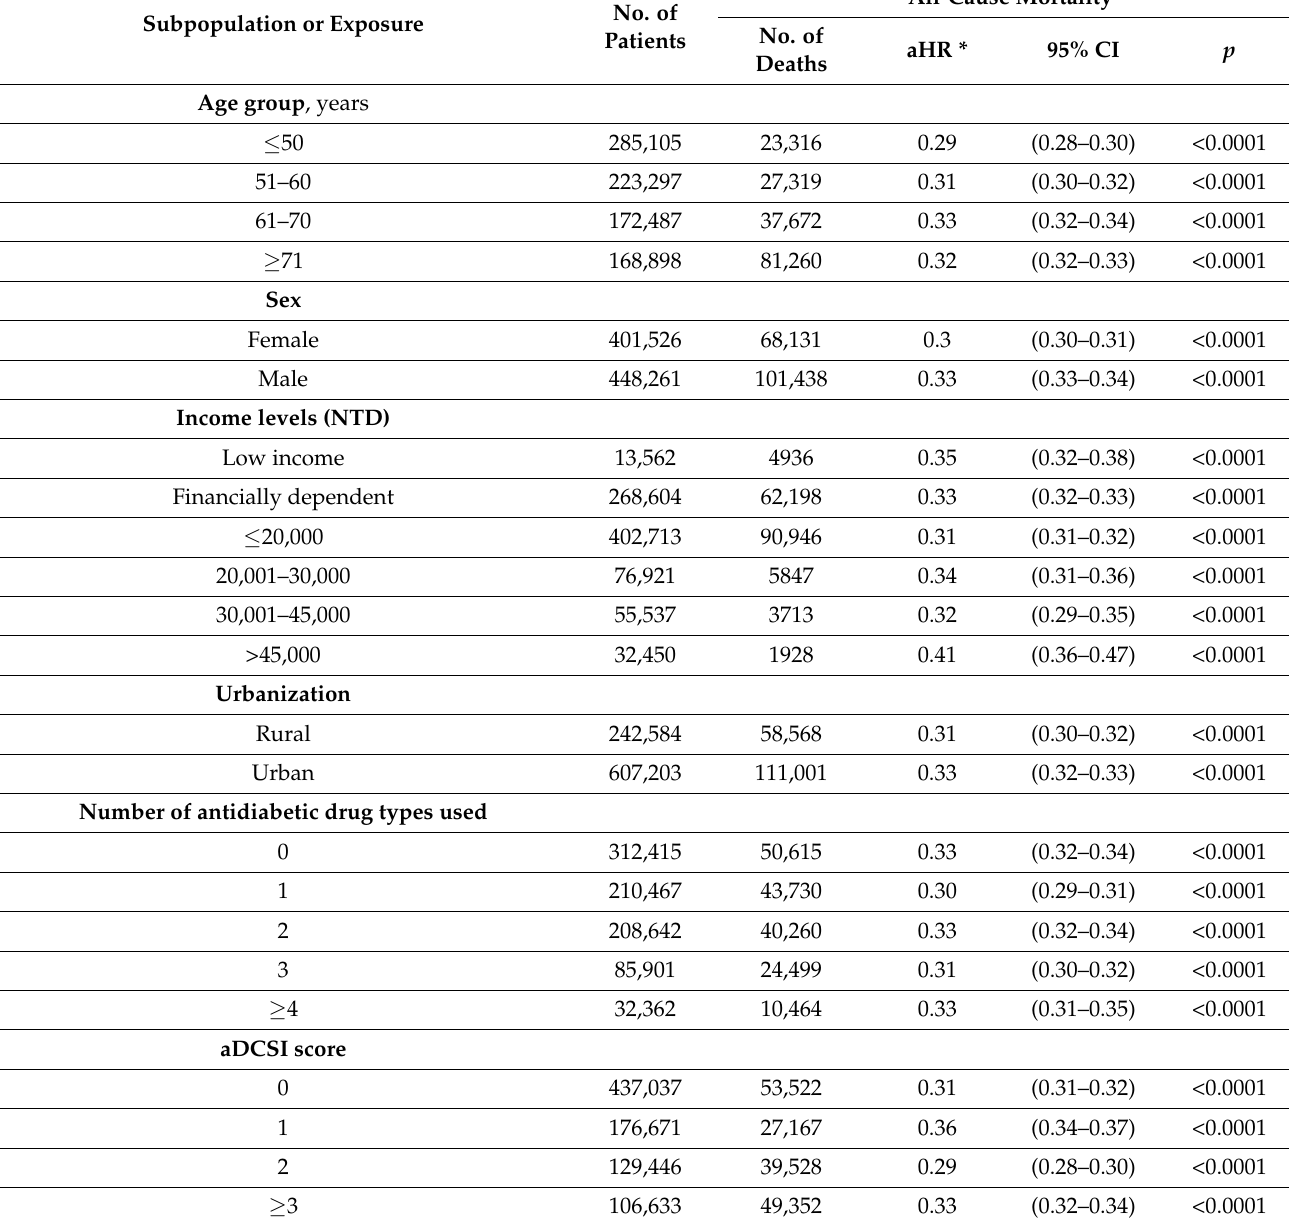
Table 3. Sensitivity analyses for statin use–all-cause mortality association in patients with type 2